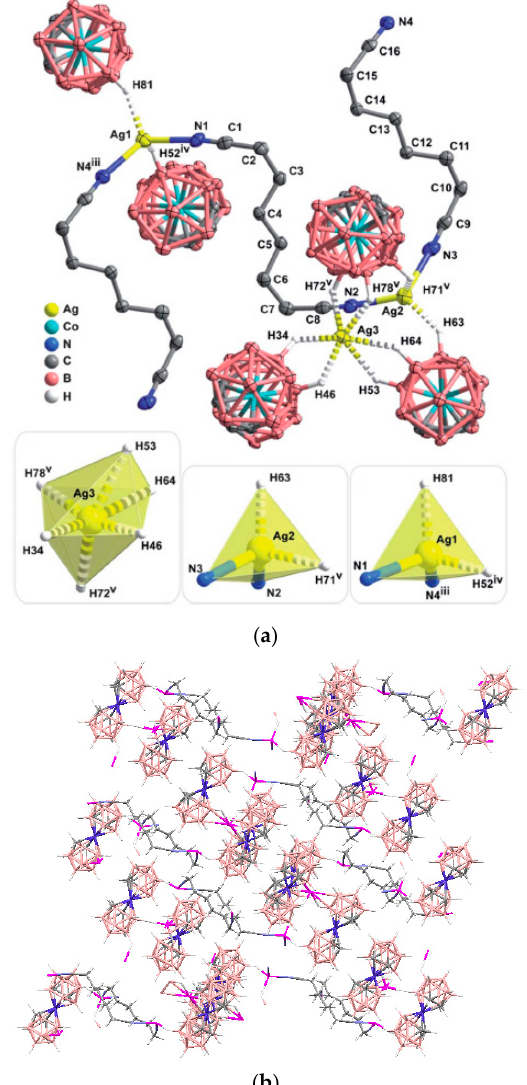
Figure 107. X-ray structure of {Ag 3 (NC(CH 2 ) 6 CN) 2 [3,3’-Co(1,2-C 2 B 9 H 11 ) 2 ] 3 } n : coordination arrangement of silver cation ( a ) and crystal packing ( b ). Reproduced from reference [123] with permission from The Royal Society of Chemistry.